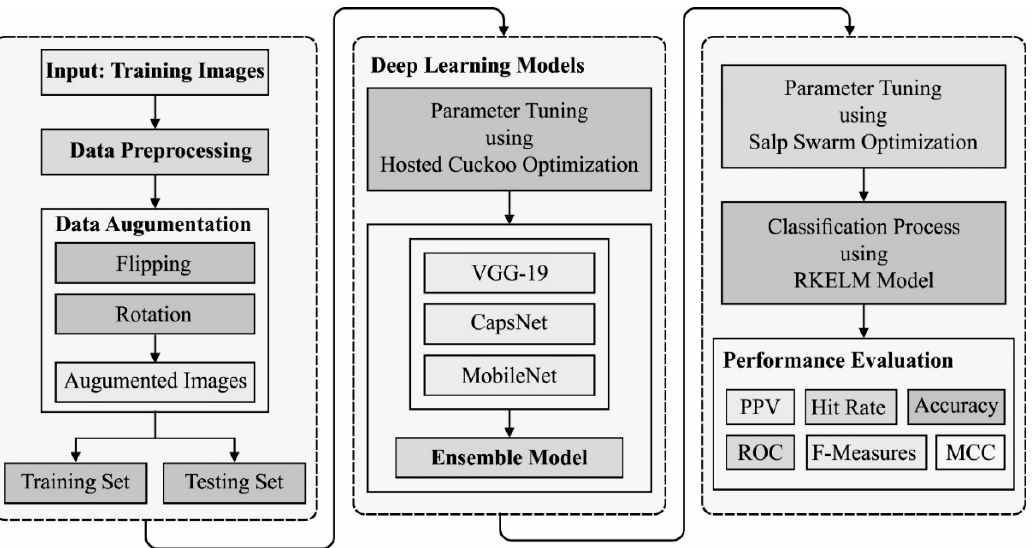
Figure 1. The overall process of the EDL-MMLCC model.